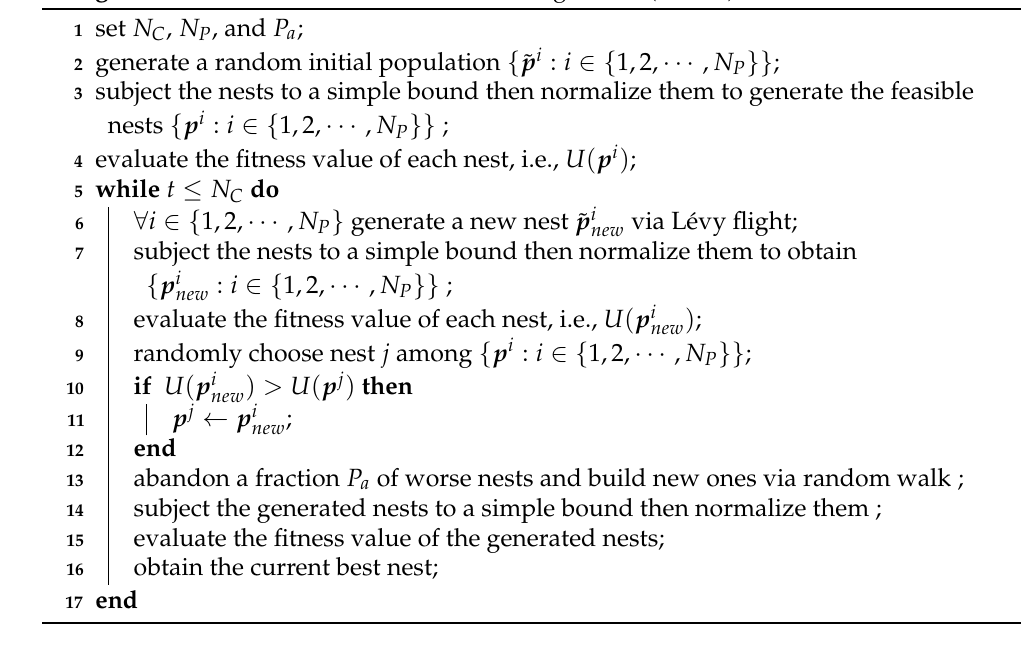
Algorithm 1: Normalized Cuckoo Search Algorithm